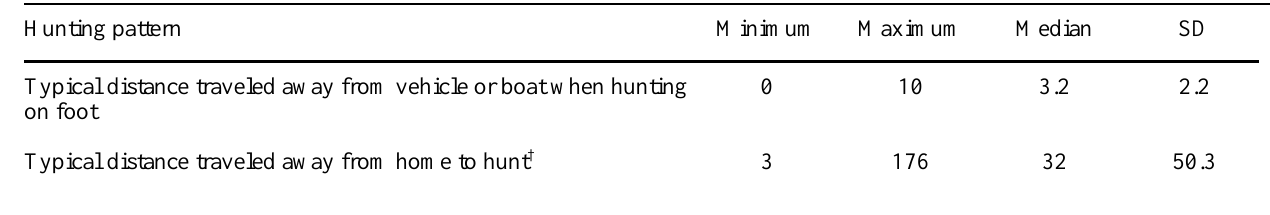
Table 1 . Distance traveled in kilometers by vehicle or boat from home to hunting area and distance traveled away from boat or vehicle on foot when hunting, according to responses from deer hunters interviewed on Prince of Wales Island,